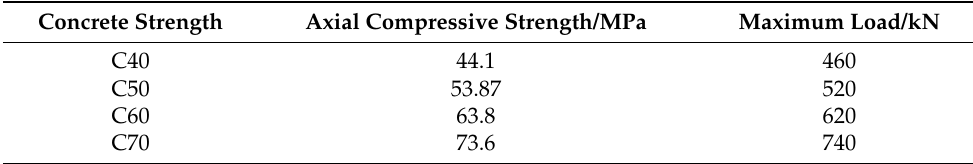
Table 2. Maximum load of each strength of